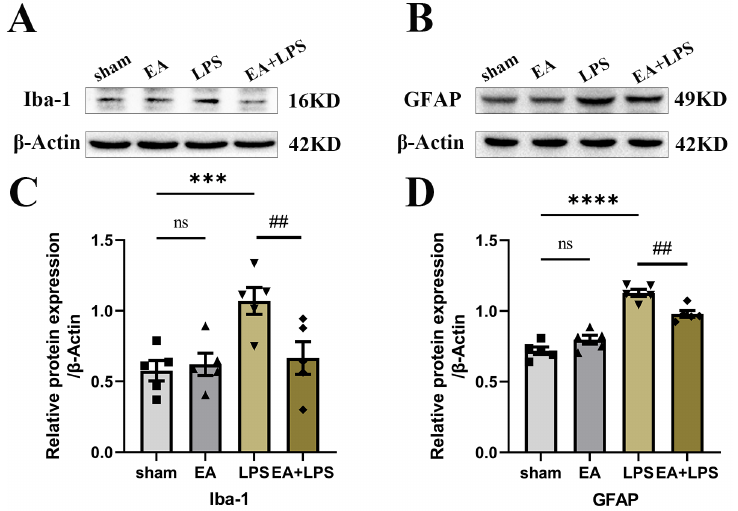
Figure 4. EA decreased pro-inflammatory cytokines in the hippocampus: n = 5 per group. ( A ) Rep- resentative blots of TNF- α . ( B ) Representative blots of IL-6. ( C ) Representative blots of IL-1 β . ( D )